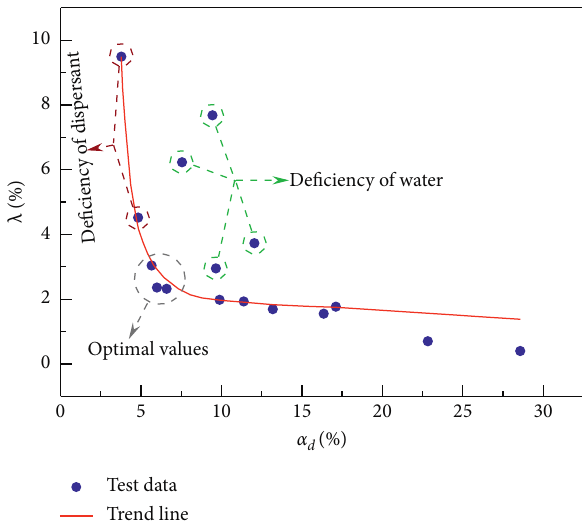
Figure 13: Correlation between the empirical stickiness ratio and dispersant mass ratio.